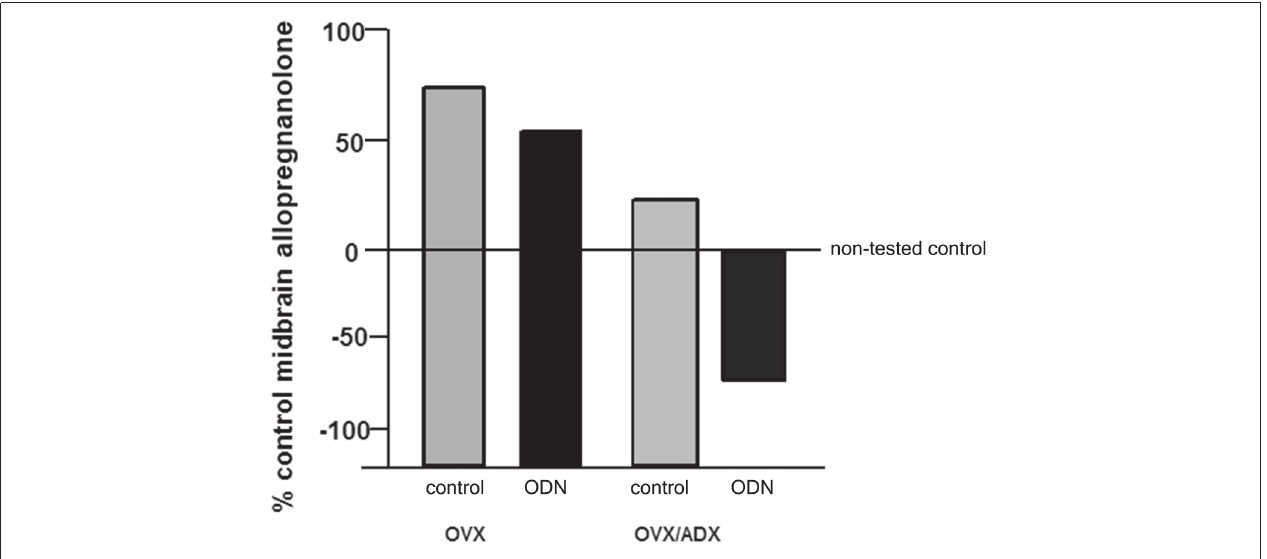
vehicle or pregnane xenobiotic receptor (PXR) antisense oligodeoxynucleotides (AS-ODNs) to the midbrain VTA. Paced mating increased midbrain allopregnanolone levels of rats compared to what was observed in the non-tested controls; this was attenuated with knockdown of